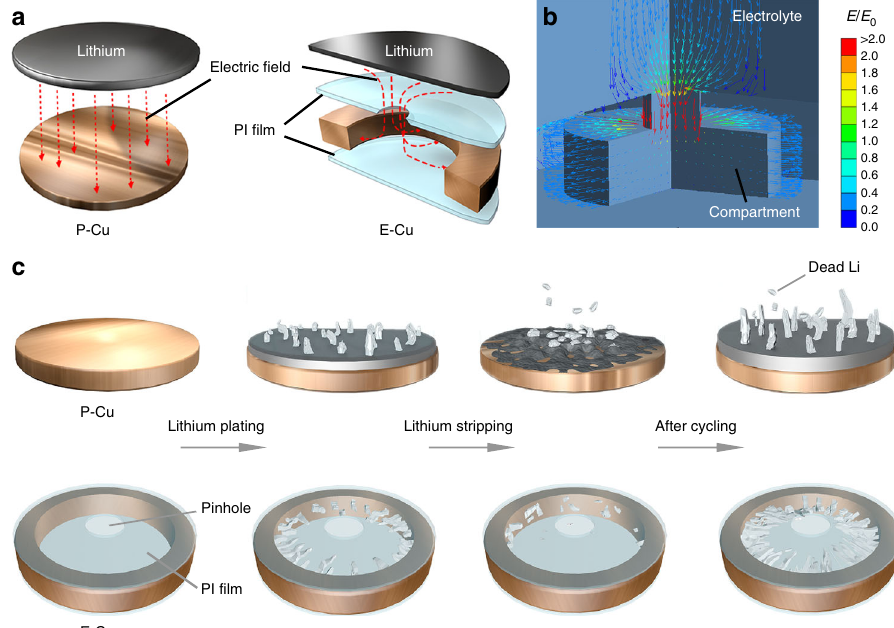
Fig. 2 Schematic electrochemical plating/stripping behaviours of Li metal anodes. a Schematic illustration of the electric fi eld distribution in P-Cu and E-Cu. b Simulated result of the electric fi eld distribution in E-Cu. c Schematic illustration of the evolution of different Li anode structures based on P-Cu and E-Cu during Li